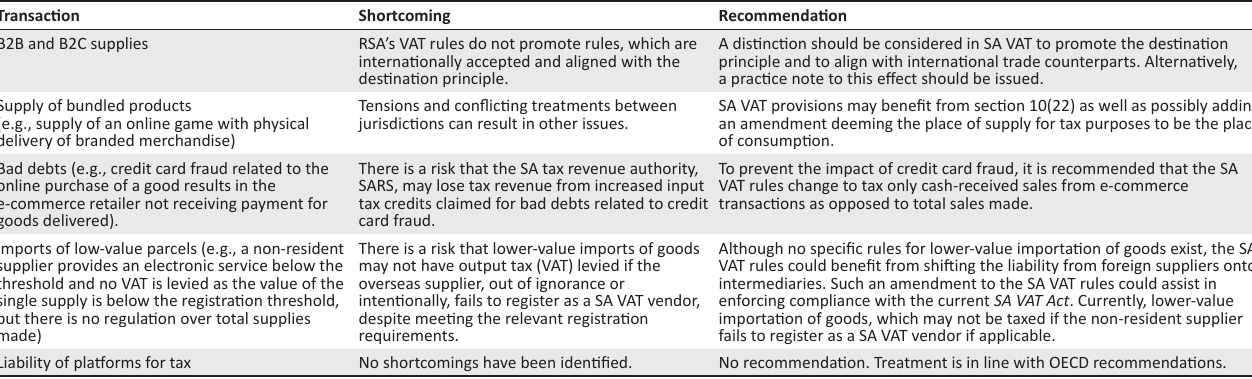
TABLE 9: A summary of